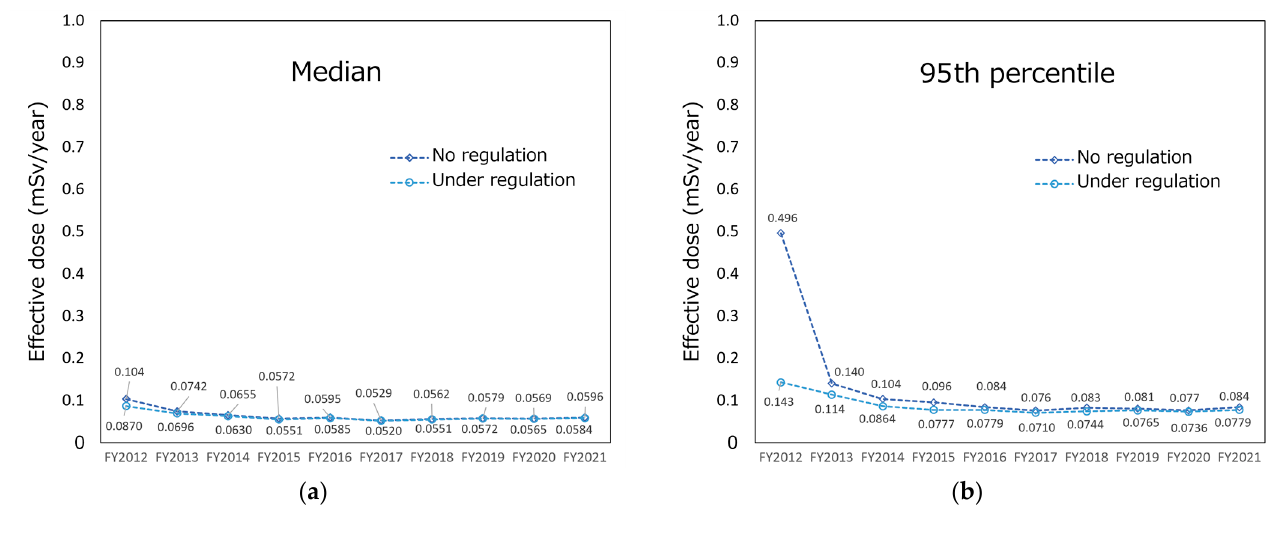
Figure 3. Trend of internal radiation exposure dose in no regulation and under regulation: ( a ) median and ( b ) 95th percentile in the radiation exposure doses of 10,000 virtual persons.